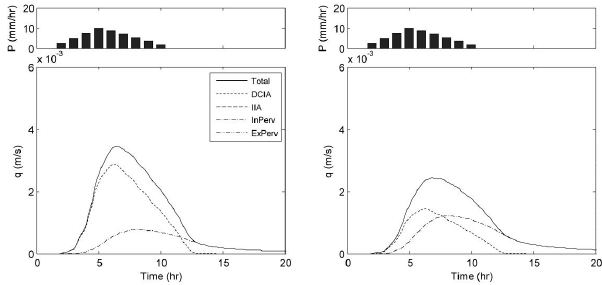
Fig. 8. Contribution from pervious and impervious areas for the storm in January 2008: (a) hydrographs for each region, (b) con- tributing ratio to total flow